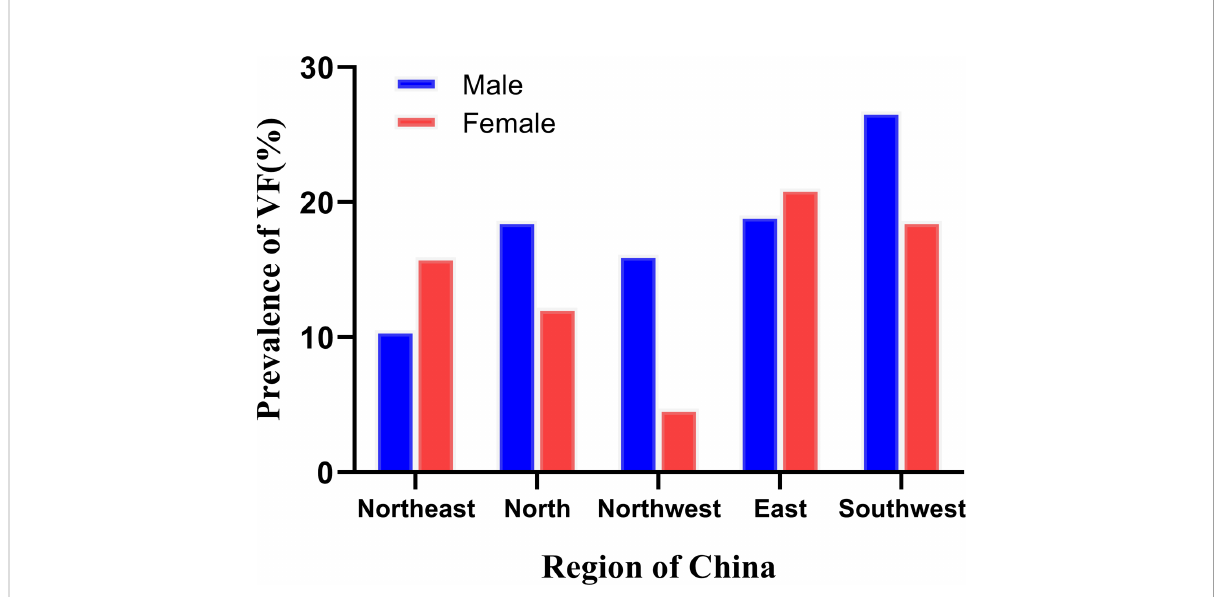
FIGURE 3 The prevalence of vertebral fracture (VF) in the ≥ 50 years group across different regions of China.